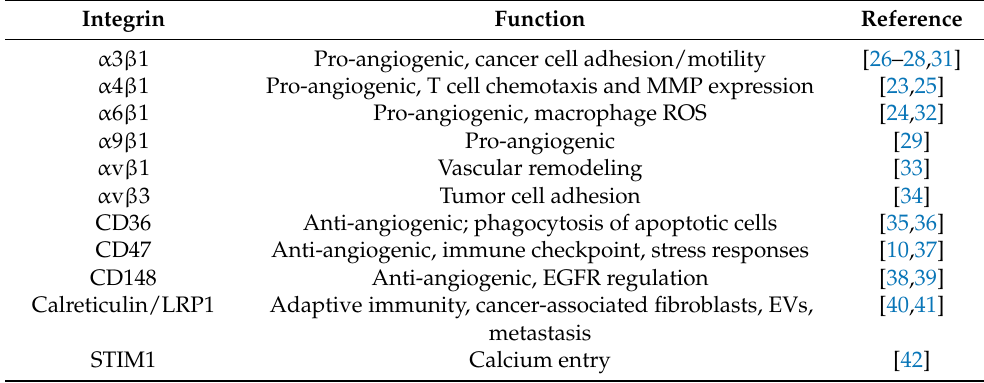
Table 1. Cell surface TSP1 receptors expressed on cancer and stromal cells.